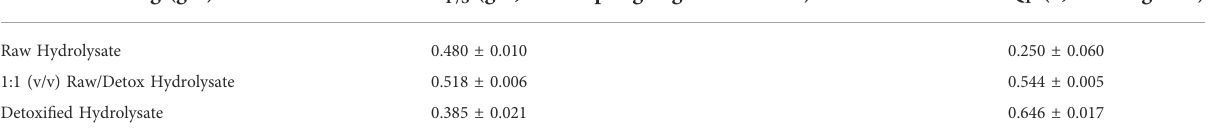
TABLE 4 Highest 2,3-butanediol product yield and volumetric productivity obtained during oxygen limited fermentation of pretreated SSB hydrolysate media. Molasses loading